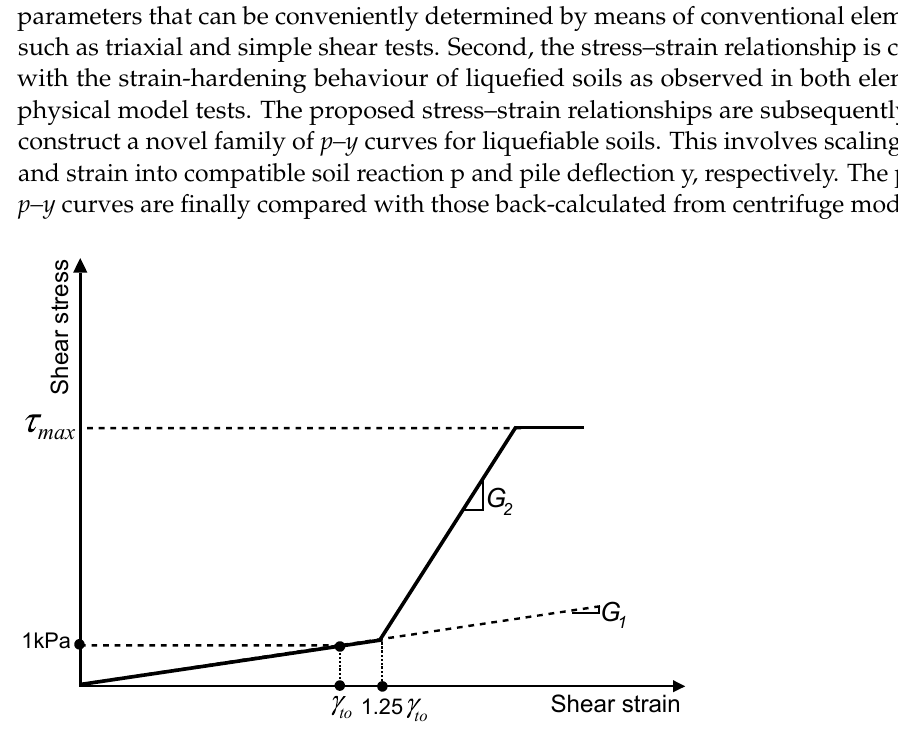
Figure 38. Monotonic stress–strain curve for liquefied soil.